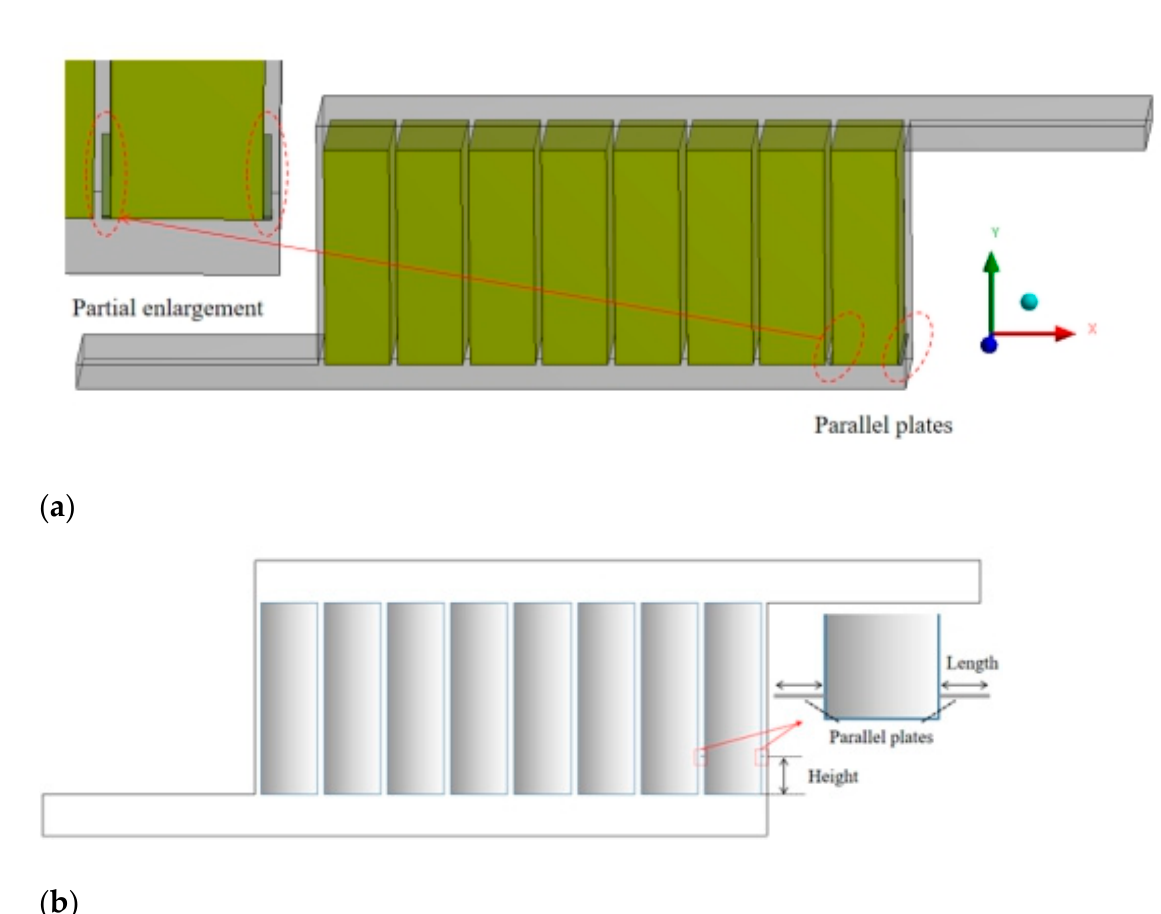
Figure 1. Diagram of the Z-type air-cooled battery thermal management system (BTMS); ( a ) 3D diagram of the Z-type air-cooled battery thermal management system (BTMS); ( b ) 2D diagram of the Z-type air-cooled battery thermal management system (BTMS).